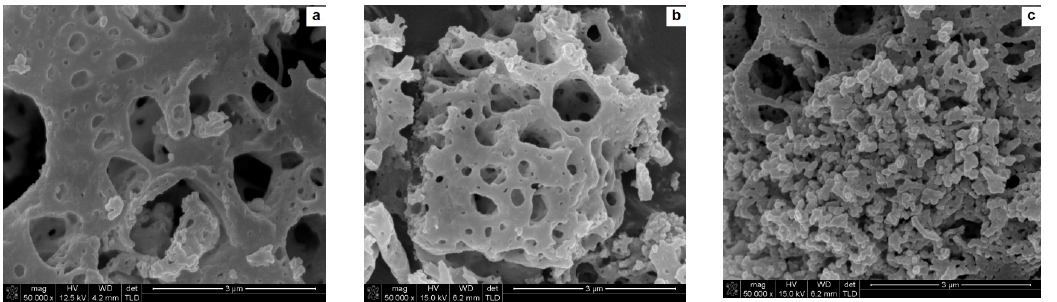
Figure 4. Micrographs of yttria nanopowder obtained by solution combustion synthesis (SCS) by the reaction of yttria nitrate with glycine: ( a ) not calcined, ( b ) calcined at a temperature of 800 °C, ( c ) calcined at a temperature of 1100 °C. Table 1. Particle size measured by method of dynamic light scattering (DLS) and calculated from BET specific surface area of yttria powders obtained by using the SCS method (Z ave —cumulants mean, Pd—polydispersity width, d V50 —median diameter of the particle size distribution, S BET —specific surface area, d BET —BET equivalent spherical particle diameter).